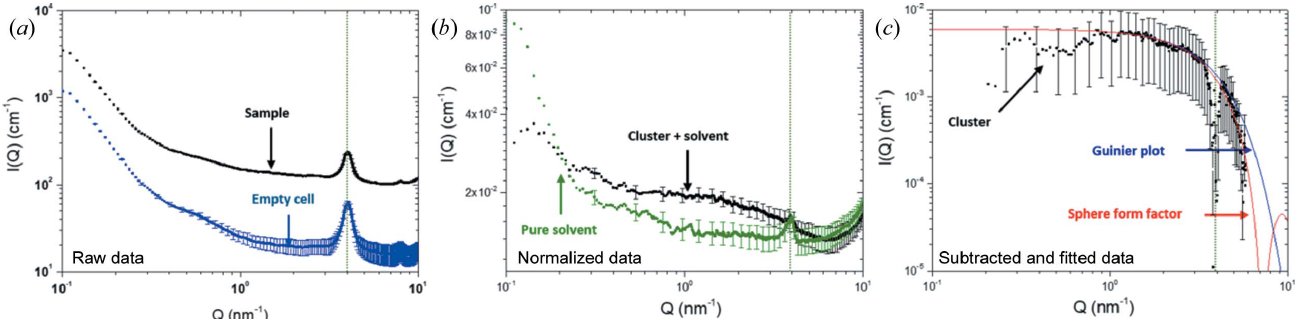
Figure 3 SAXS data for the plutonium cluster solution at different processing steps. ( a ) Raw data for the sample (black) and empty cell (blue) in arbitrary units (a.u.). ( b ) Normalized data in absolute units after empty-cell subtraction for the cluster sample (black) and the pure solvent (green). ( c ) The cluster signal (black) after subtraction of the solvent contribution, and the fitting models: sphere form factor (red line) and Guinier plot (blue line). The vertical dotted line in each graph corresponds to the expected position of the Kapton scattering